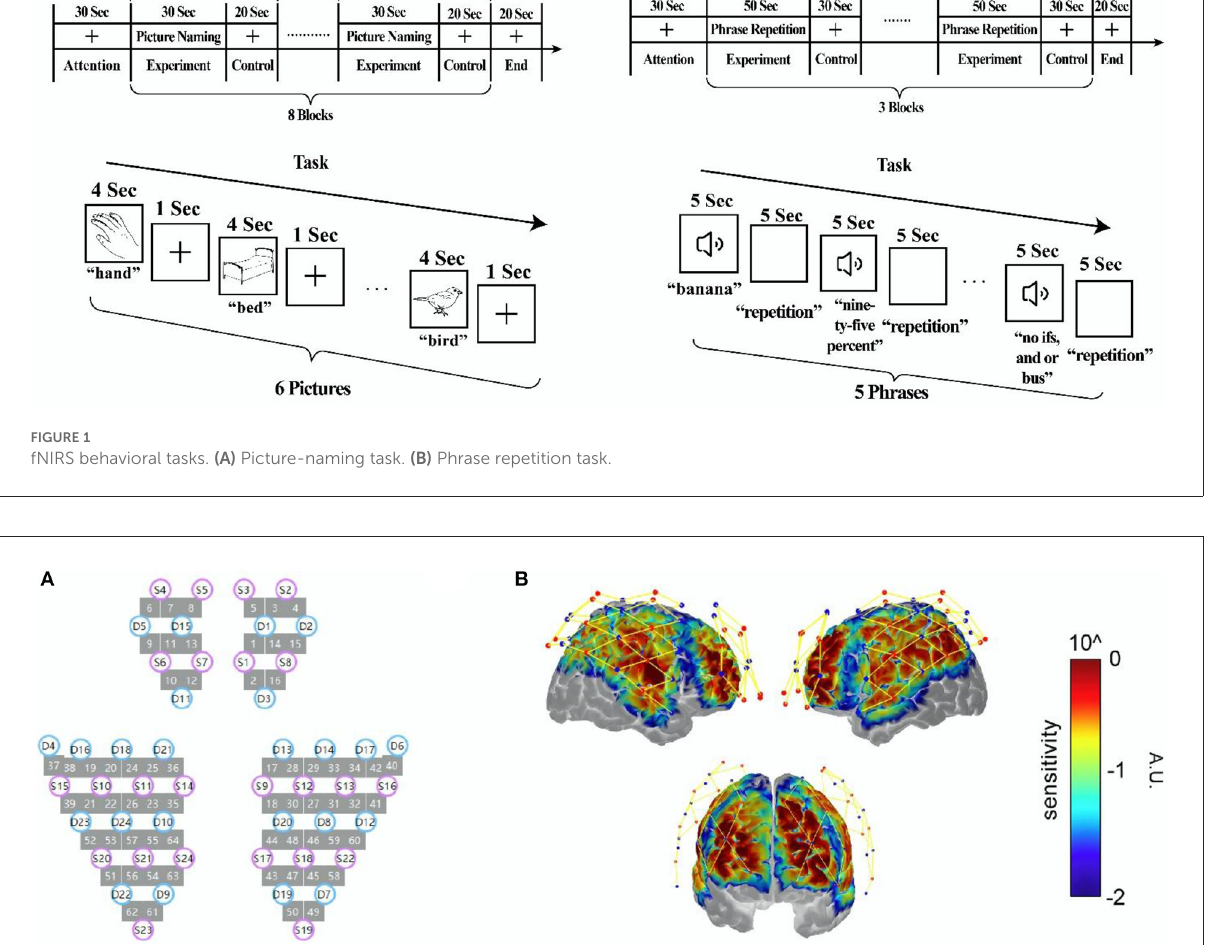
FIGURE2 (A) fNIRS probe design; sources are represented by S, while detectors are represented by D and channels with lines between S and D. The arrangement of the optodes with an interoptode distance of 30mm. (B) Sensitivity profile; sources are displayed with red dots, while detectors are displayed with blue dots and channels with yellow lines. Results of the Monte Carlo simulation based on 1 × 10 − 8 photons over the frontal, parietal, temporal, and occipital lobes: colors represent the spatial sensitivity of the fNIRS measurements. Warmer colors suggest higher sensitivity to the cortex, while cooler colors suggest lower sensitivity to the